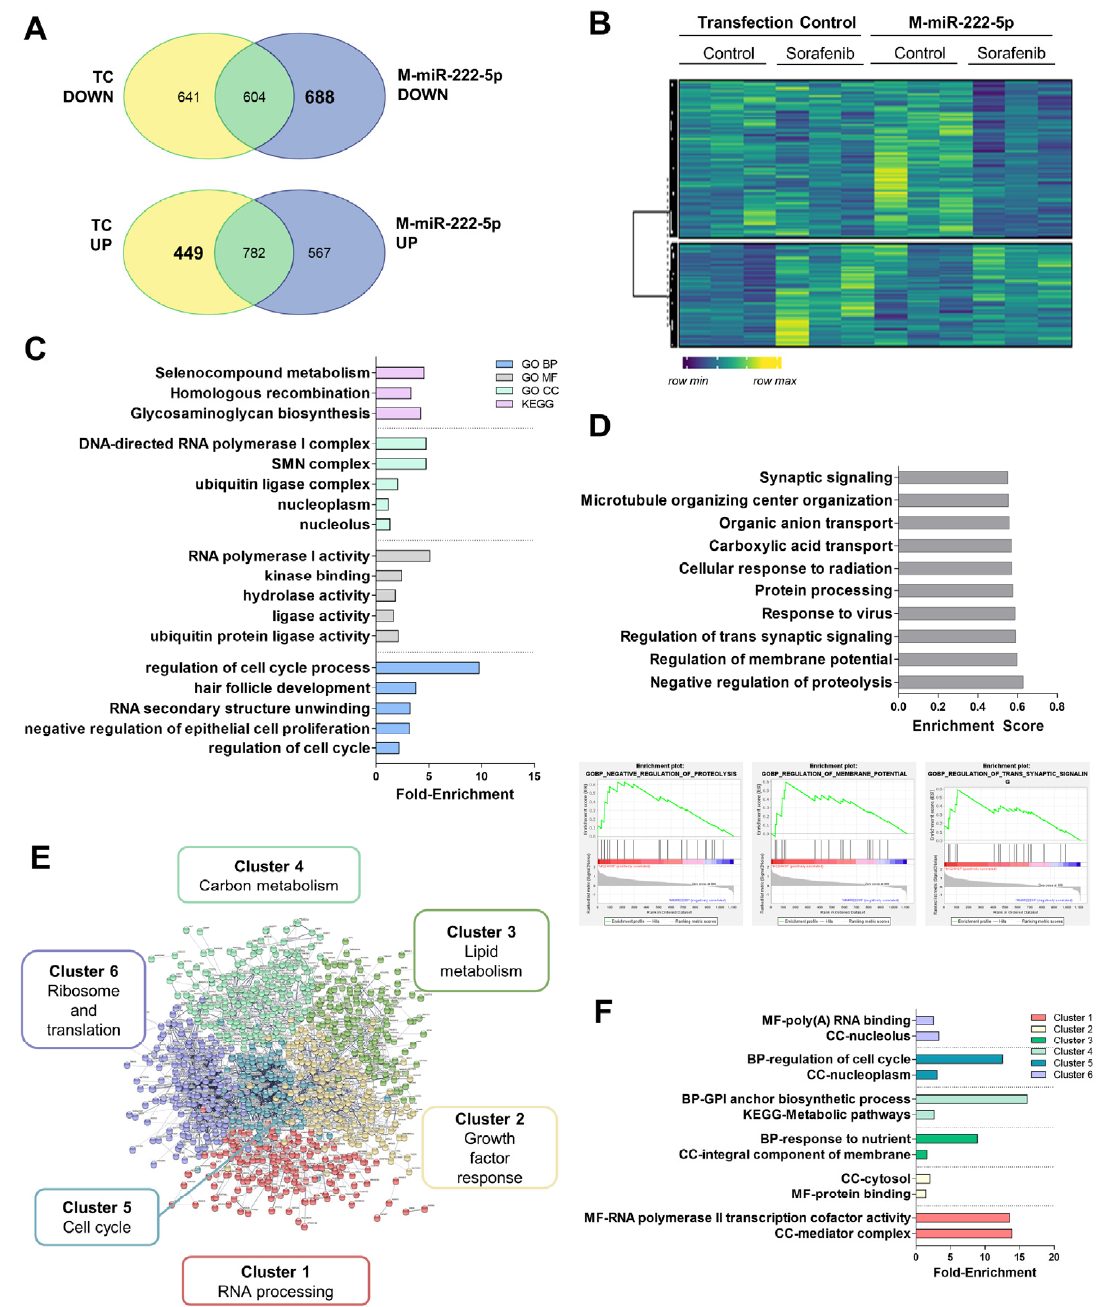
Figure 7. RNA-sequencing data of miR-222-5p overexpression in HepG2 cells showed altered cell cycle and metabolic control. ( A ) Venn diagrams showing mRNAs regulated upon miR-222-5p mimics (M-miR-222-5p) compared to the transfection control (TC). ( B ) Heatmap of genes regulated by miR-222-5p. ( C ) Fold-enrichment values of the top five most significantly enriched GO BP, MF, CC, and KEGG pathways. ( D ) Top 10 significant hallmarks of GSEA downregulated after M-miR-222-5p. Plots were provided for the three most enriched terms. ( E ) Diagram showing clustering of the STRING analysis. ( F ) Fold-enrichment values of the top two most significantly enriched terms either in the GO BP, MF, CC, or KEGG pathways in each STRING cluster. Experiments were carried out as three independent replicates.